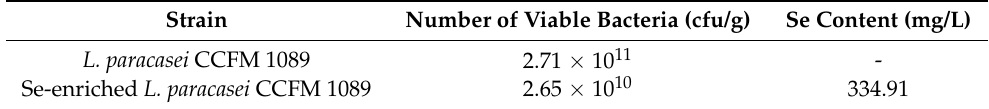
Table 2. Viable bacteria and Se content of CCFM 1089 powder.